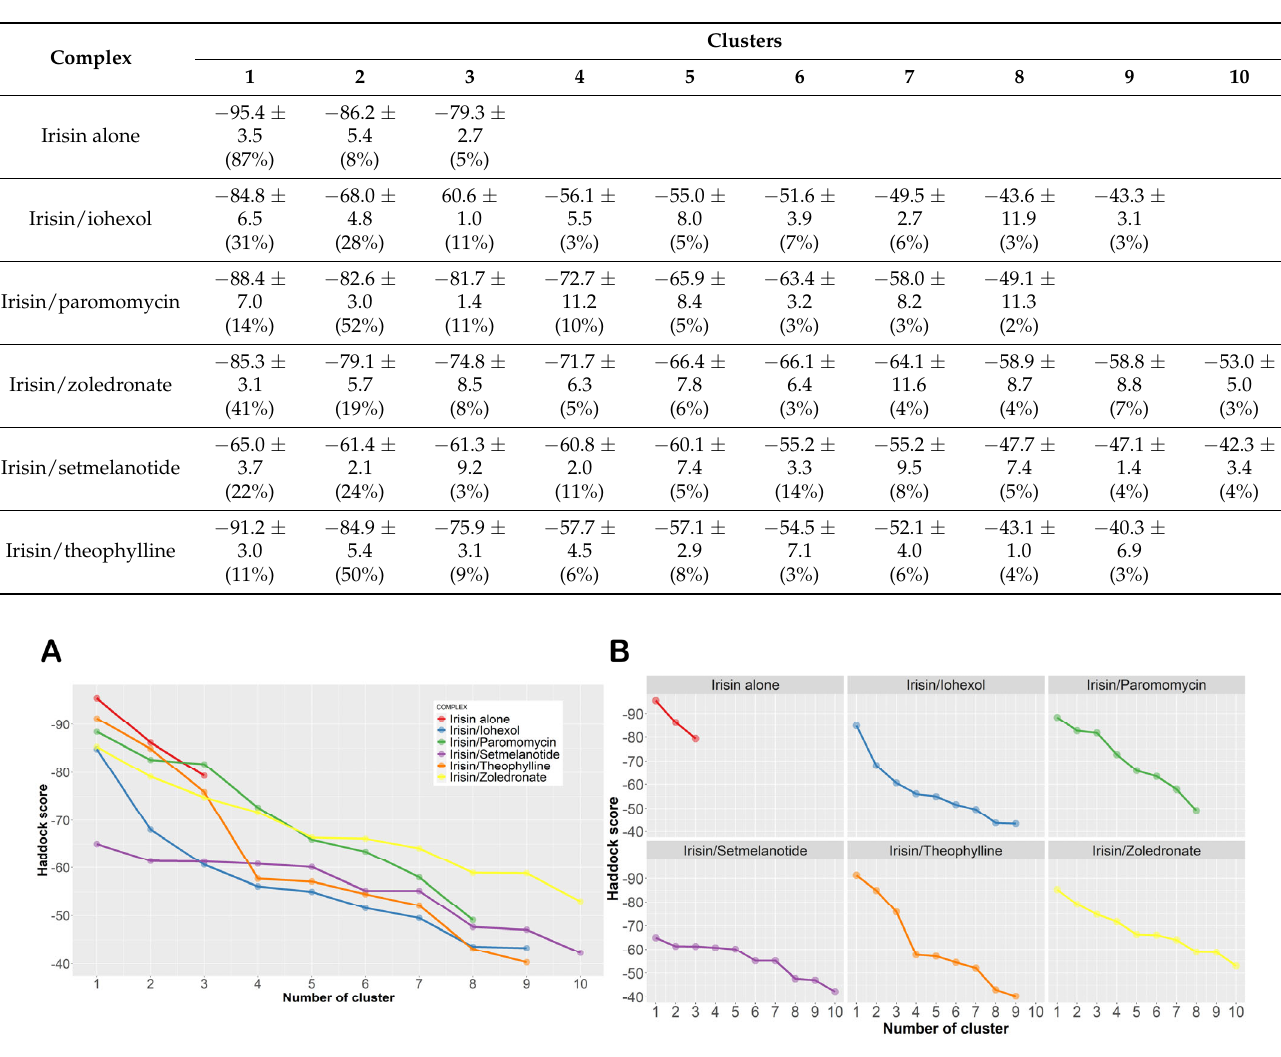
Table 4. HADDOCK outputs regarding the protein–protein docking of irisin monomers alone and in the presence of the selected FDA-approved drugs. Clusters are ordered by the Z-scores provided by HADDOCK.